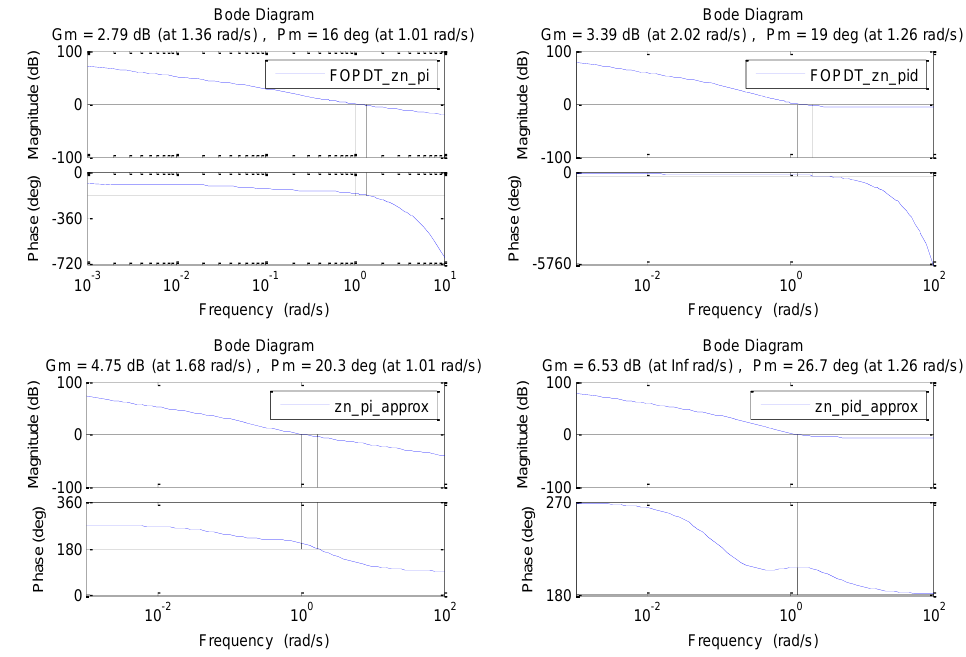
Figure 7. Bode plots of G(s) and G Pade’s (s) with ZN controller